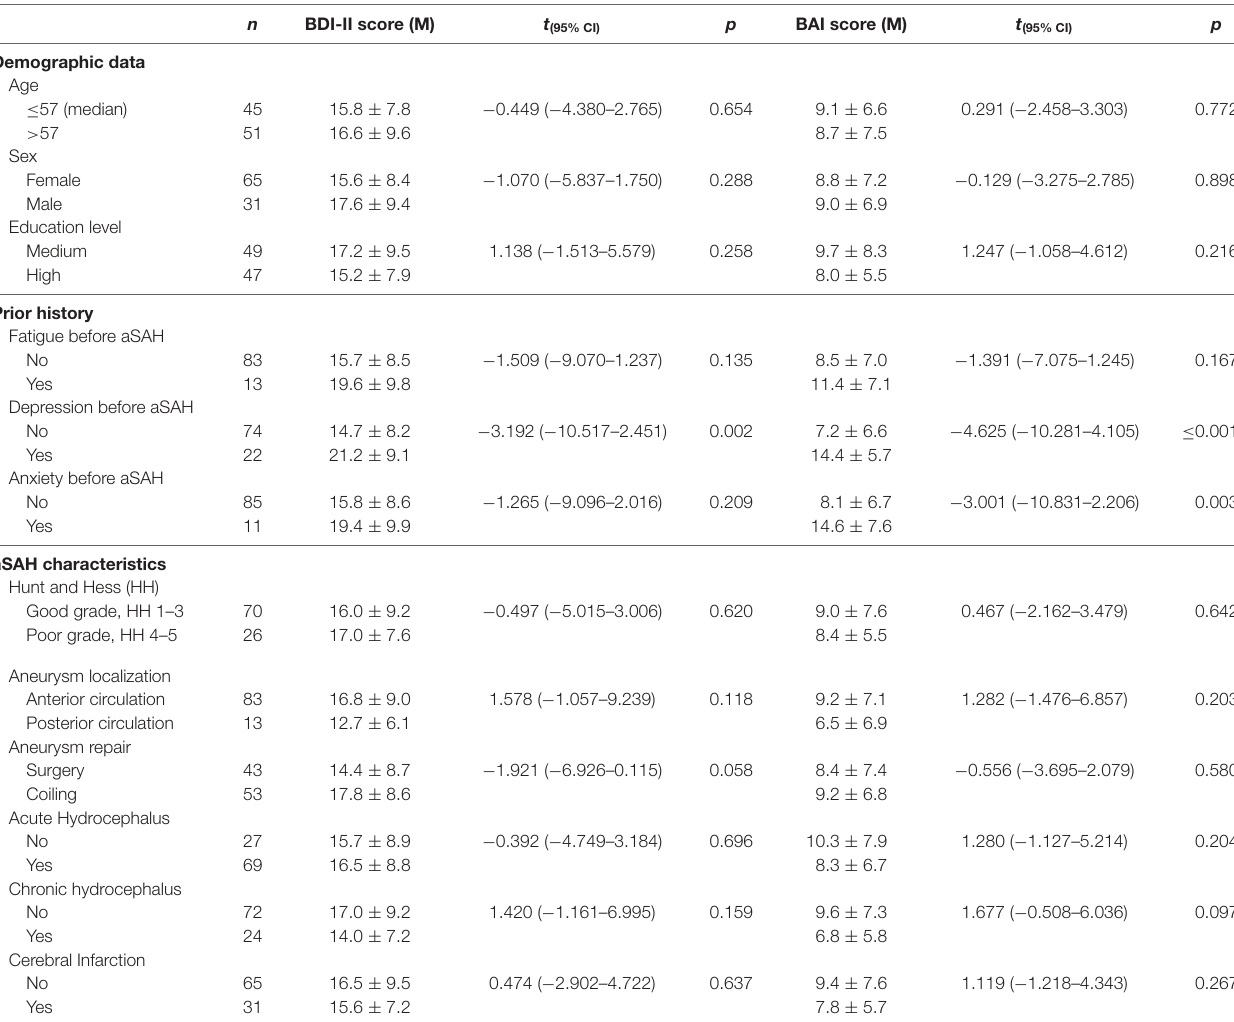
TABLE 3 | Relationship between symptoms of depression and anxiety (BDI-II and BAI scores), demographics, prior history of fatigue and mood disorders, and hemorrhage characteristics. n BDI-II score (M) t (95%CI) p BAI score (M) t (95%CI)